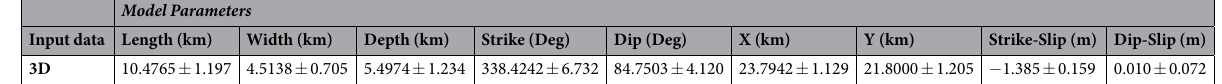
Model Parameters